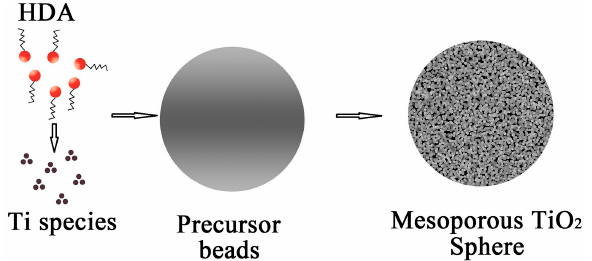
Figure 1. Schematic representation of the formation mechanism of the mesoporous spherical TiO 2 .